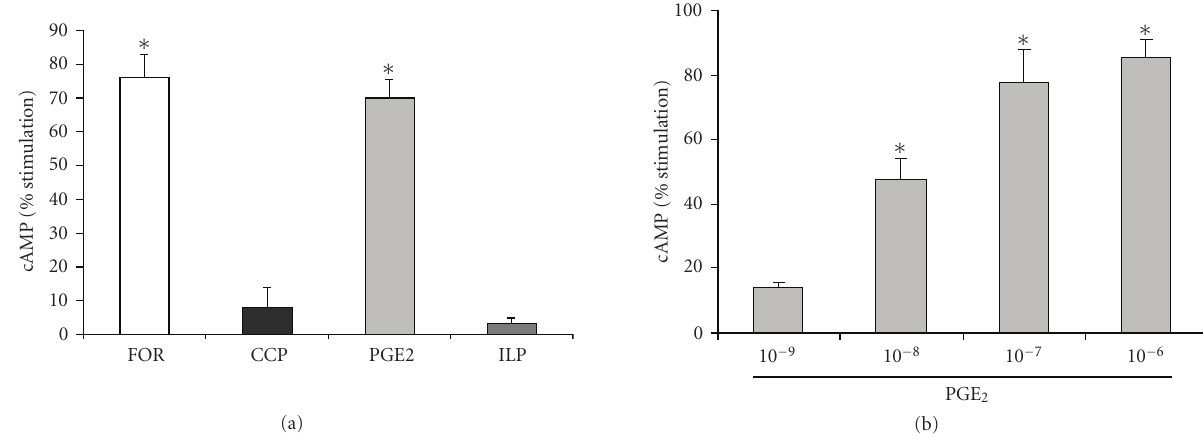
Figure 2: PGE 2 stimulates cAMP in IMCD-K2 cells.Serum-starved cells were stimulated for ten minutes with (a) 10 − 6 M of di ff erent prostanoids (cicaprost (CCP), iloprost (ILP), and PGE 2 ) or 10 − 5 M forskolin (FOR), and with (b) di ff ering concentrations of PGE 2 (10 − 9 to 10 − 6 M). A competitive binding assay with 3 H-cAMP was performed and the percent cAMP stimulation was determined using a scintillation counter. Values are means ± S.E.M.; n = 3–4. ∗ P < . 05 compared to